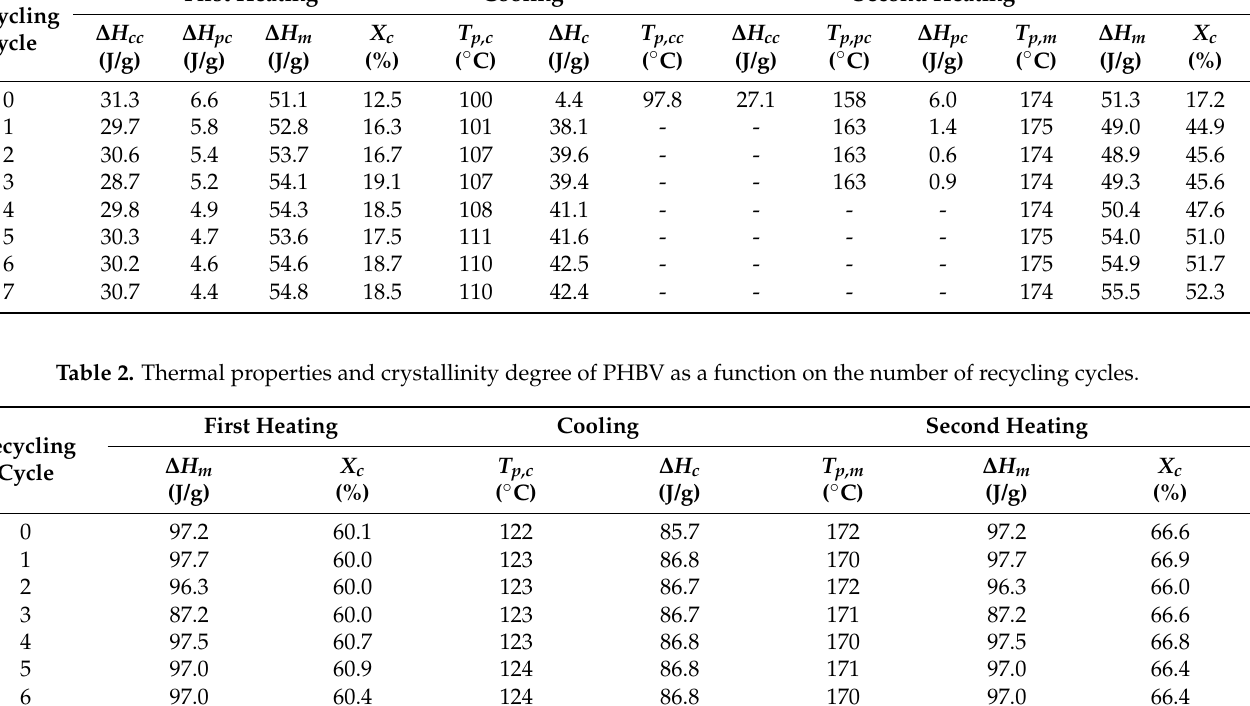
Table 1. Thermal properties and crystallinity degree of PLLA as a function on the number of recycling cycles. Recycling Cycle